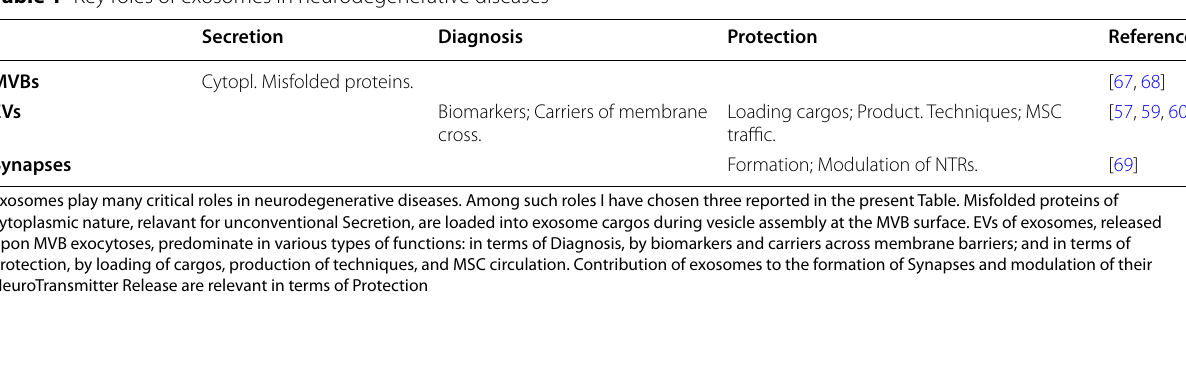
Table 1 Key roles of exosomes in neurodegenerative diseases